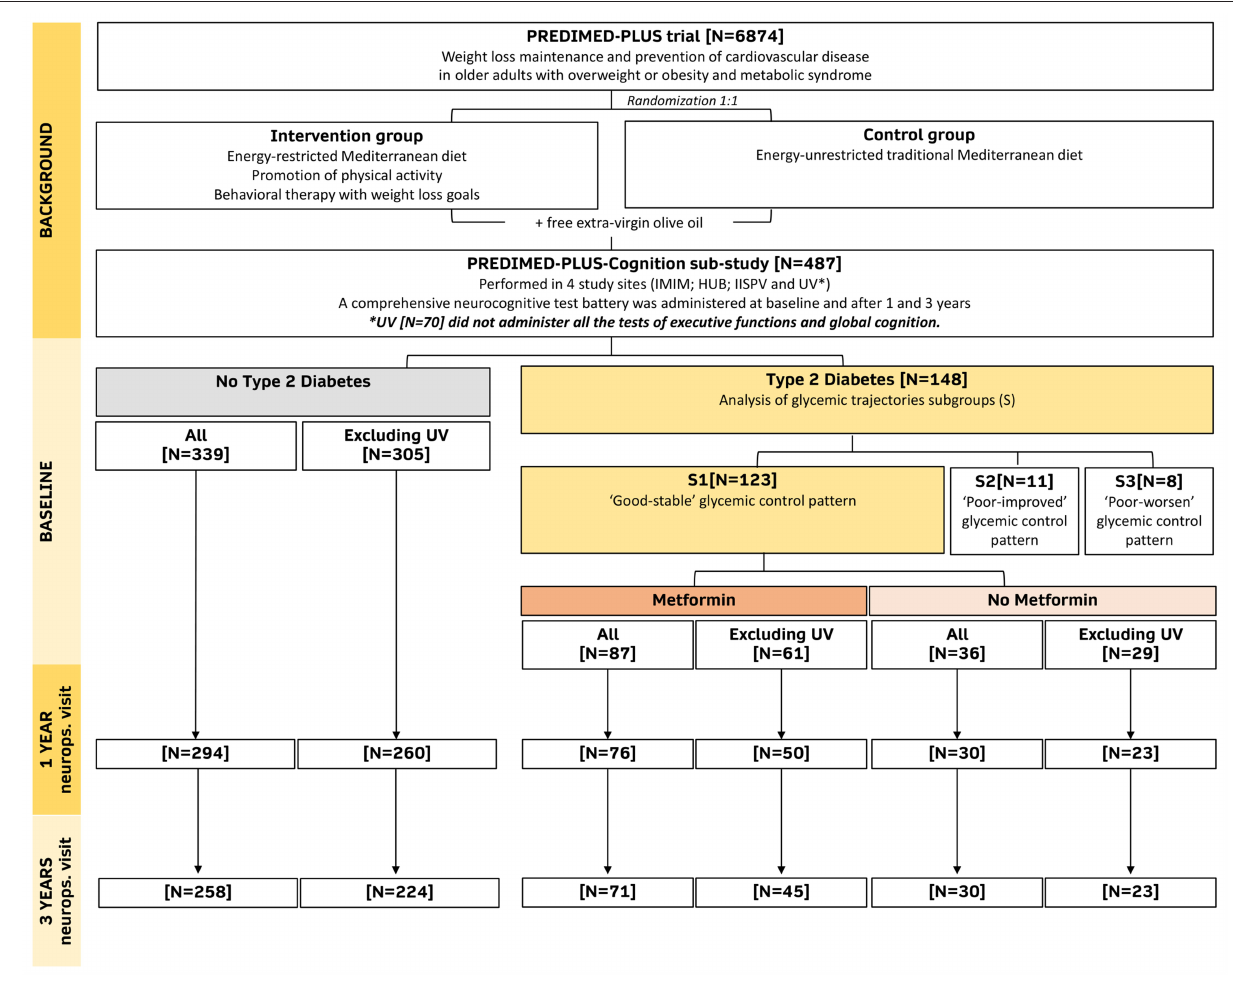
FIGURE 1 | Study flow diagram including the follow-up in the neuropsychological visits (neurops. visit) after 1 and 3 years of intervention. IMIM, Hospital del Mar Medical Research Institute. IISPV, Pere Virgili Institute for Health Research. UV, University of Valencia. HUB, Bellvitge University